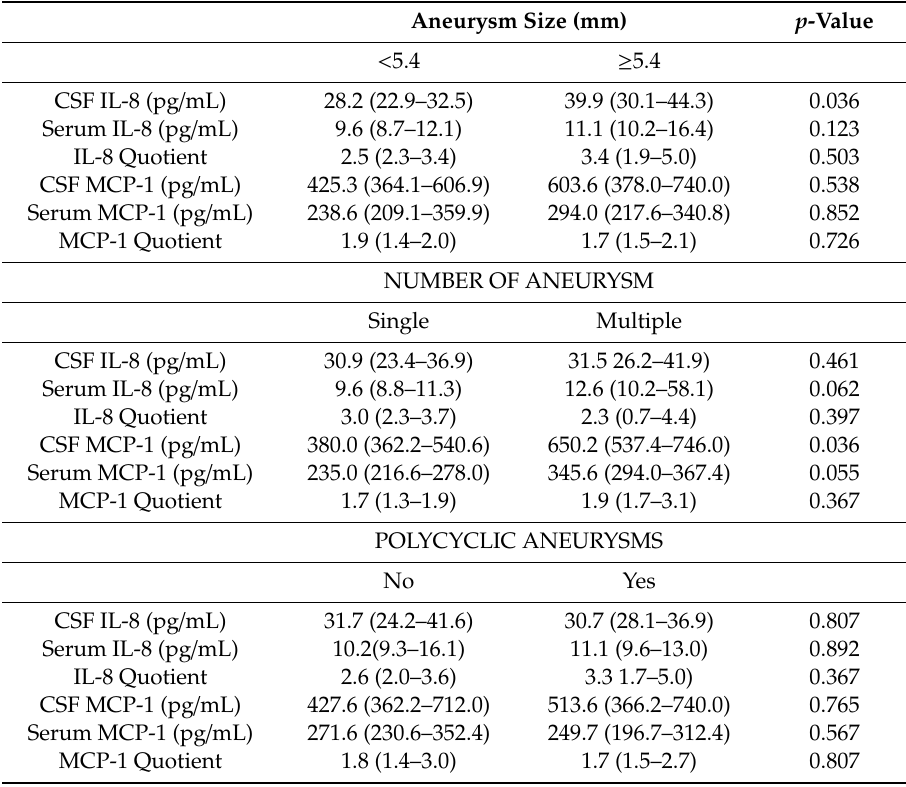
Table 6. CSF and serum IL-8 and MCP-1 concentrations and Quotient values depending on aneurysm’s size median value and aneurysm number and shape.